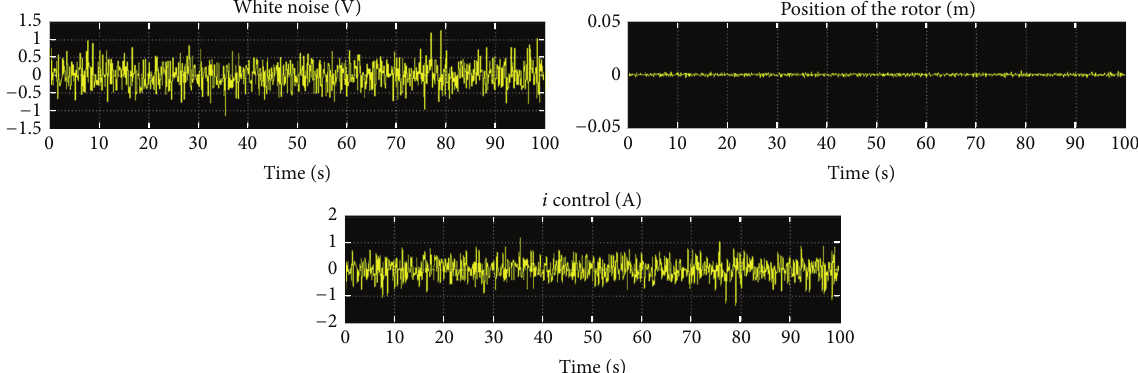
Figure 14: System response with PID controller with proportional gain of 319.0187, integral gain of 1273.2977, and differential gain of 7.2565 and white noise of 0.01 volts.